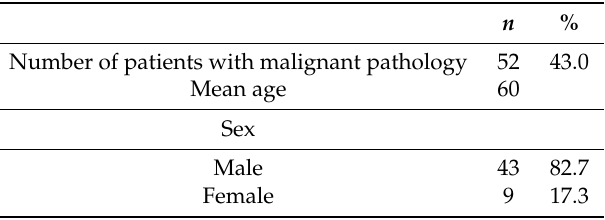
Table 1. Characteristics of the study set of